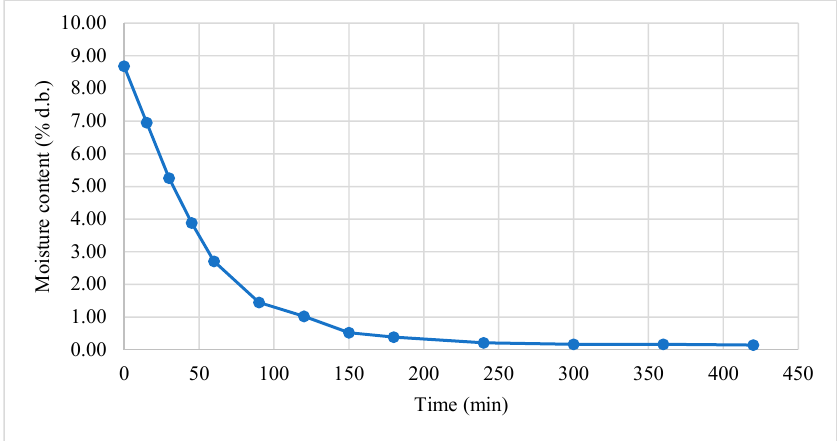
Figure 2. Drying curve of greenhouse solar dryers .